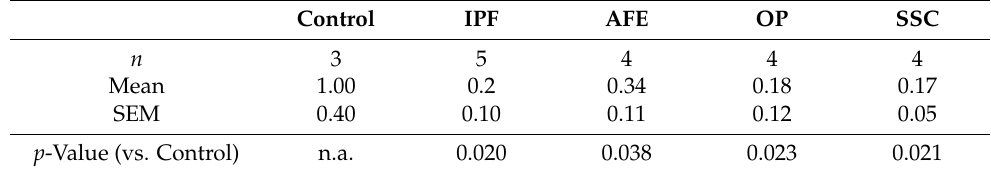
Table 4. PLK2 gene expression in different human pulmonary fibrosis